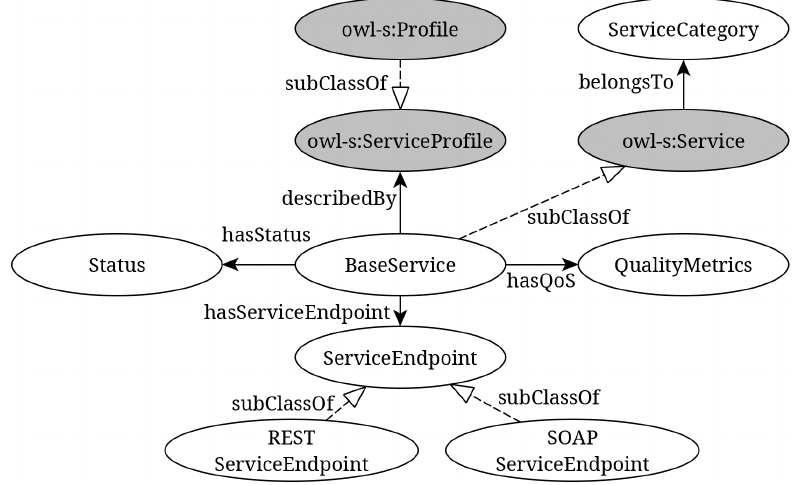
Figure 4. Part of the Base Service Ontology concepts and their relations.